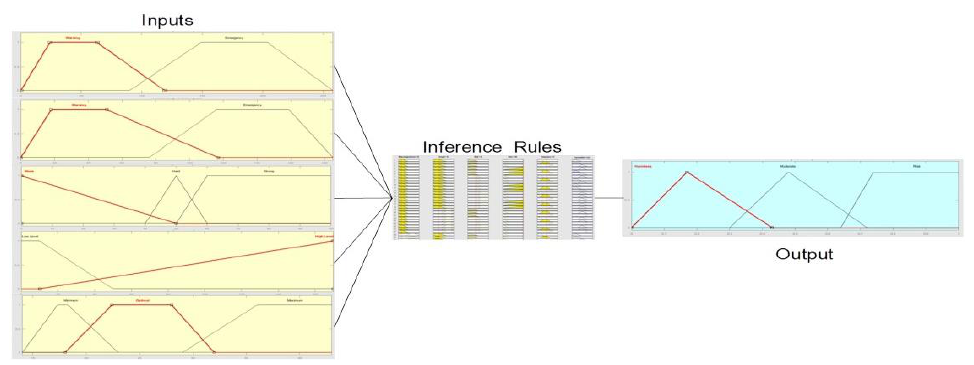
Figure 4. Graphic representation of fuzzy models.